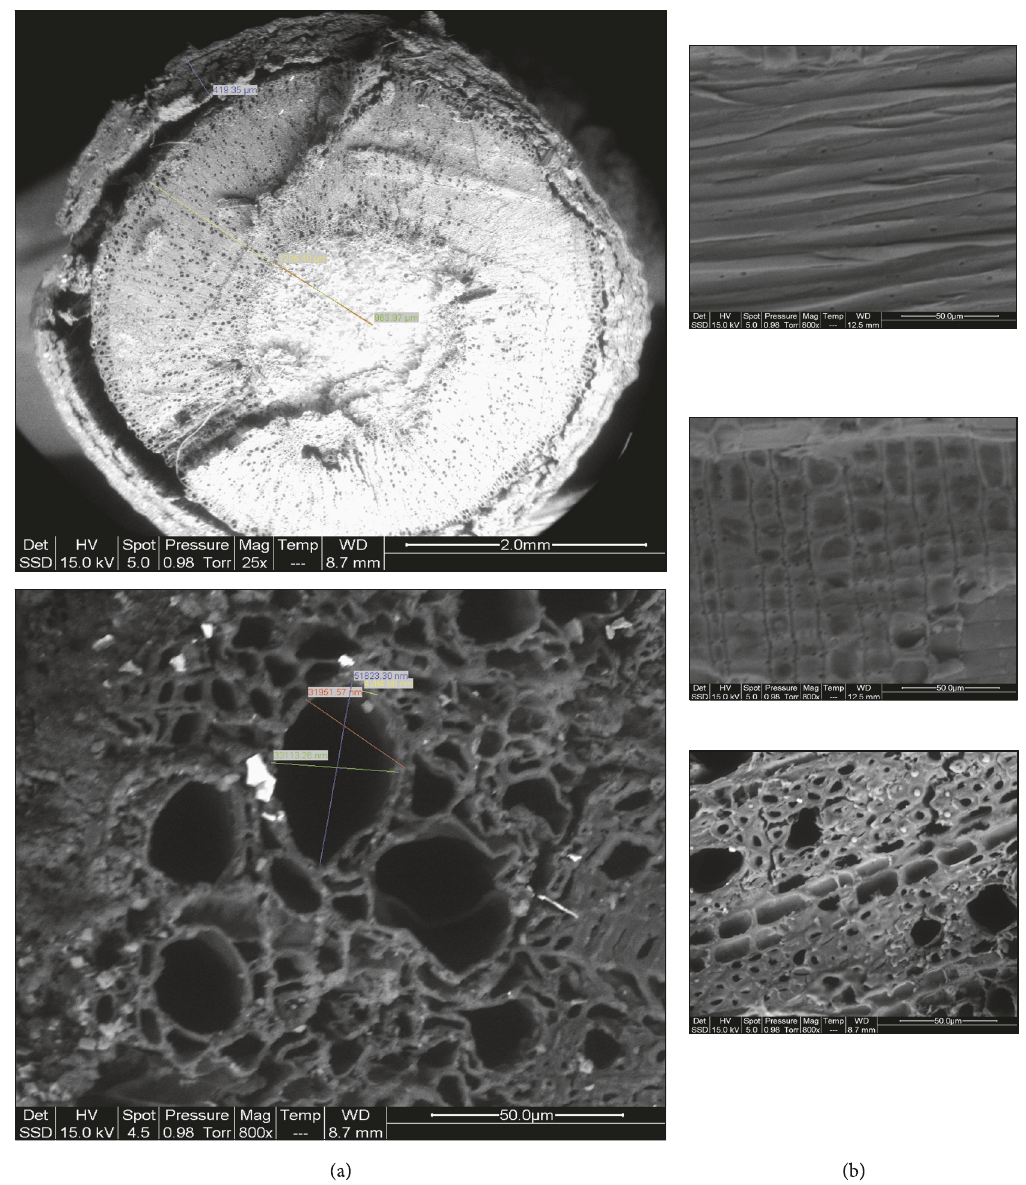
Figure 1: Macroscopic observation of the Prunus amygdalus : (a) cross section and (b) radial longitudinal